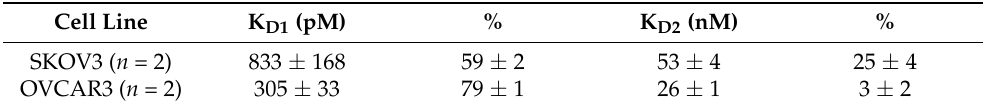
Table 1. Equilibrium dissociation constants (K D ) for the interaction between [ 125 I]I-Ec1-LoPE and OVCAR3 and SKOV3 cells.